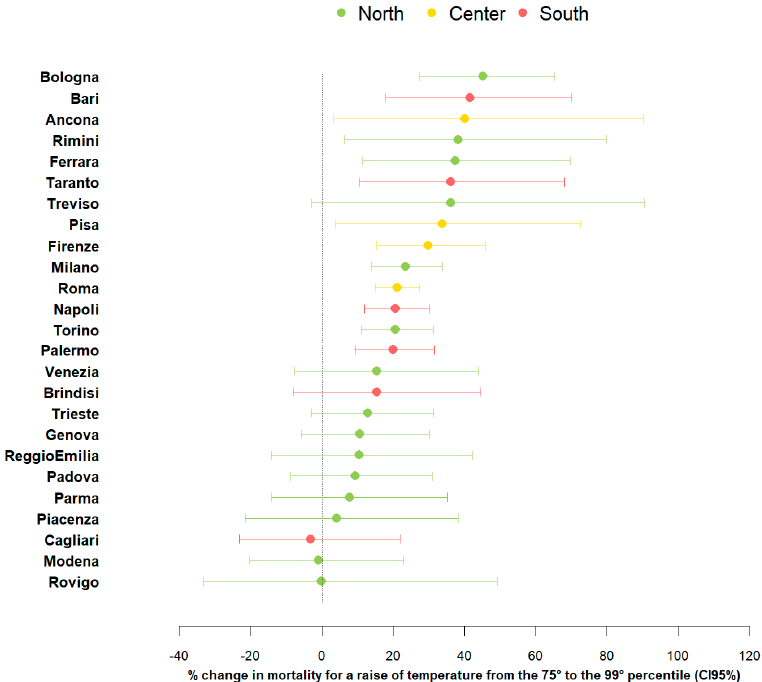
Figure 2. City-specific estimates of the heat effects. Estimates are given as % change in non-accidental mortality, and 95% confidence intervals (95% CI) for mean air temperature increases between the 75th and 99th percentile of city-specific temperature distributions.